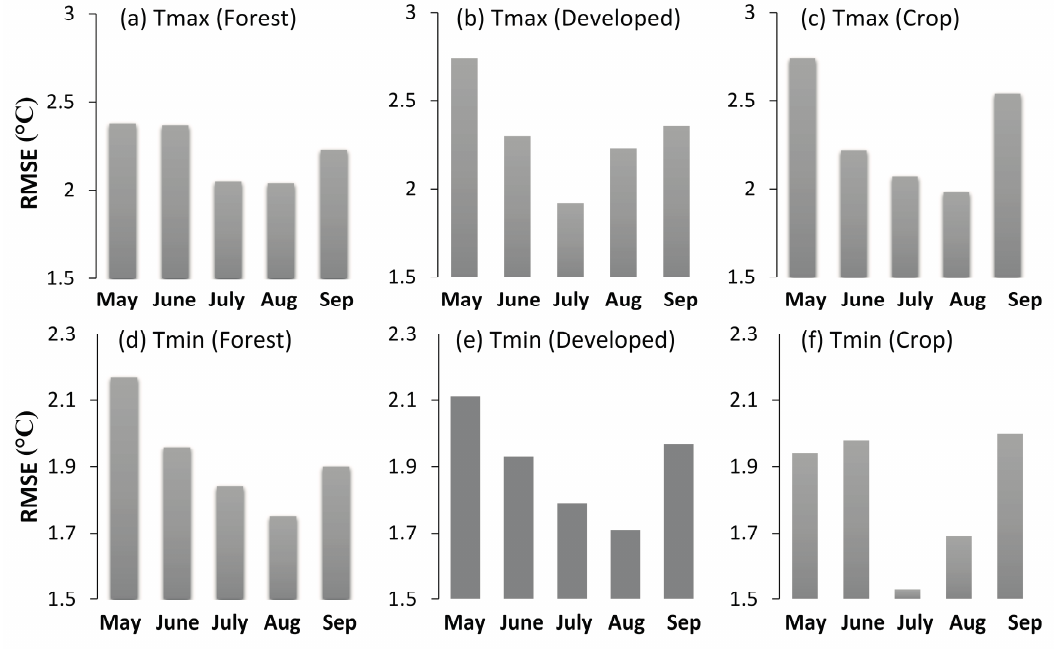
Figure 3. Accuracy of estimated Tmax ( a – c ) and Tmin ( d – f ) (RMSE, °C) in different months from 2008 to 2012 over three land-cover types (forest, developed and crop).